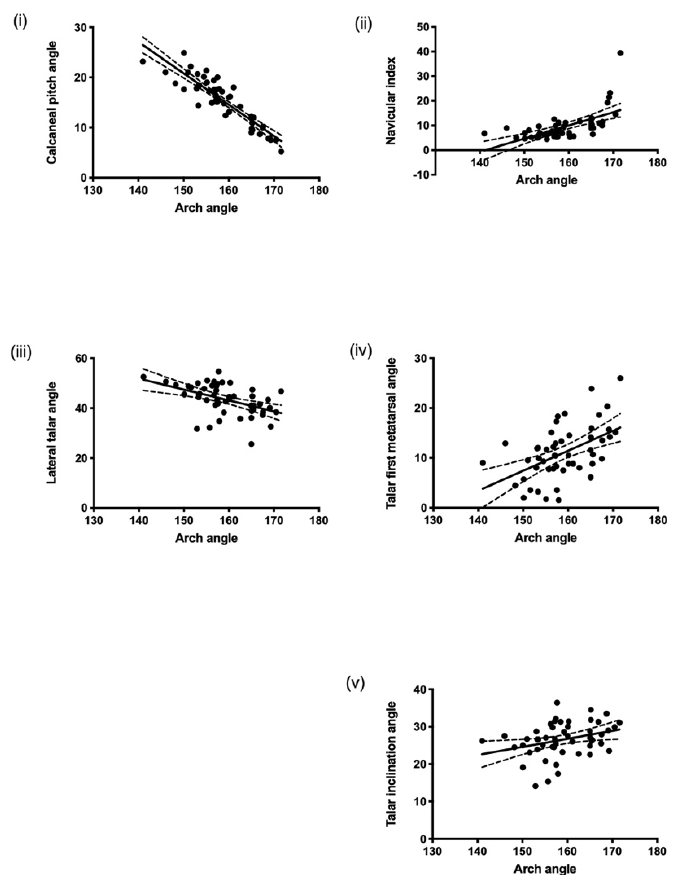
Figure 3. Correlation of arch angle with ( i ) calcaneal pitch angle, ( ii ) navicular index, ( iii ) lateral talar angle, ( iv ) talar-first metatarsal angle, and ( v ) talar inclination angle.